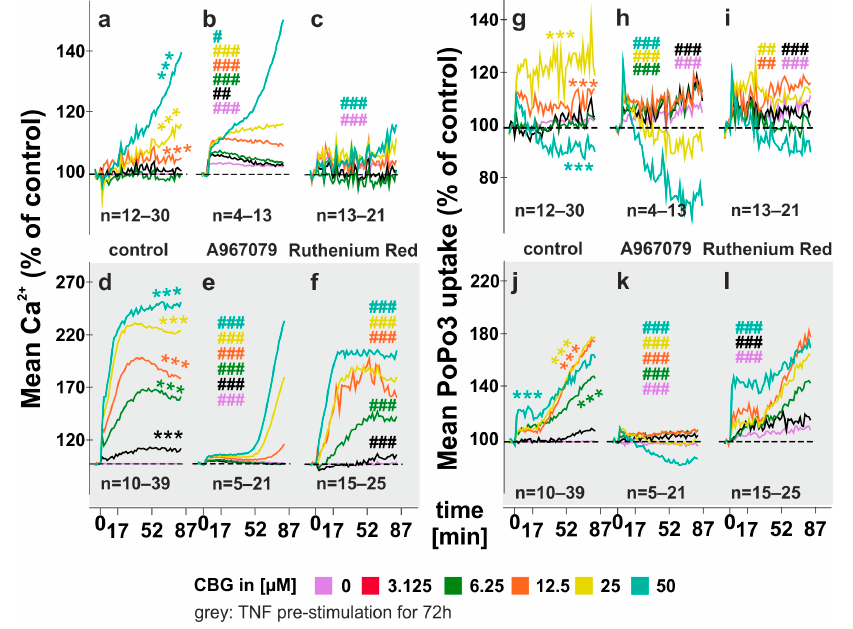
Figure 1. Intracellular calcium levels and PoPo3 uptake of RASF under the influence of CBG In- fluence of CBG on intracellular calcium levels ( a – f ) and PoPo3 uptake ( g – l ). RASF was simulated by using Hanks balanced salt solution (HBSS). The TRPA1 inhibitor A967079 or pan TRP inhibitor ruthenium red were added 30 min prior to the addition of CBG. *** p < 0.001 for differences between concentrations of CBG. ANOVA with Dunnett’s T3 post hoc test was used for comparisons. # p < 0.05, ## p < 0.01, ### p < 0.001 for comparisons of CBG versus CBG/antagonist treatment at each concen- tration. ANOVA with the Bonferroni post hoc test was used for comparisons. Number of patients included: ( a , g ) n = 12 and n = 30 (no CBG); ( b , h ) n = 4 and n = 13 (no CBG) ( c , i ) n = 13 and n = 21